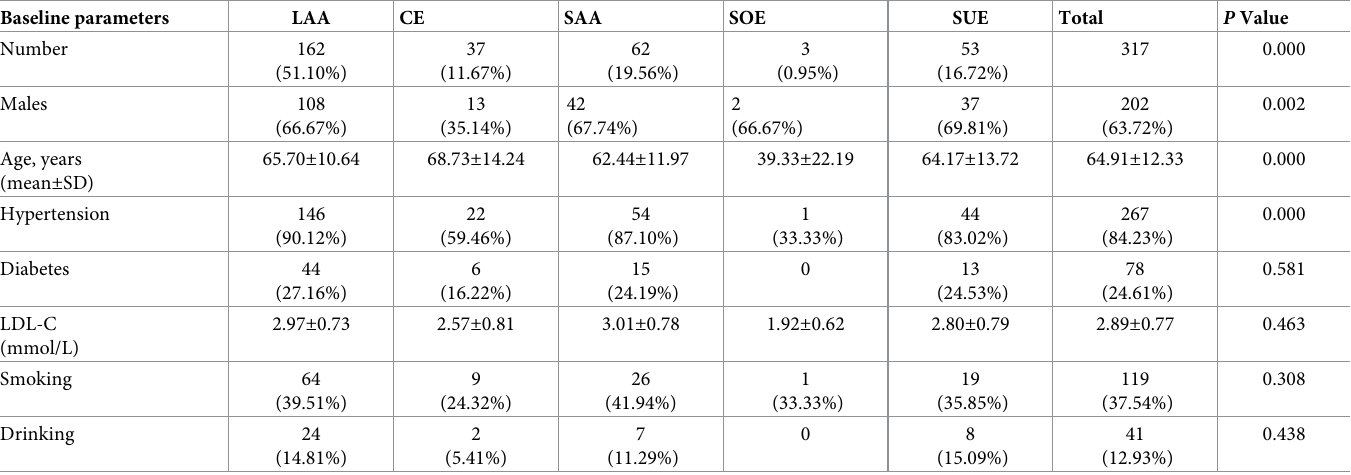
Table 2. Baseline data of various stroke subtypes.